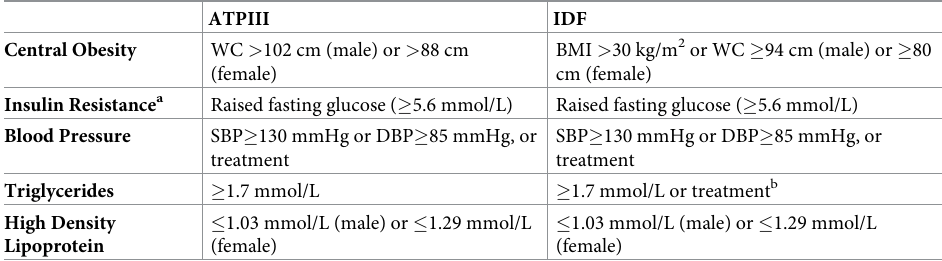
Table 1. ATPIII and IDF criteria for diagnosis of metabolic